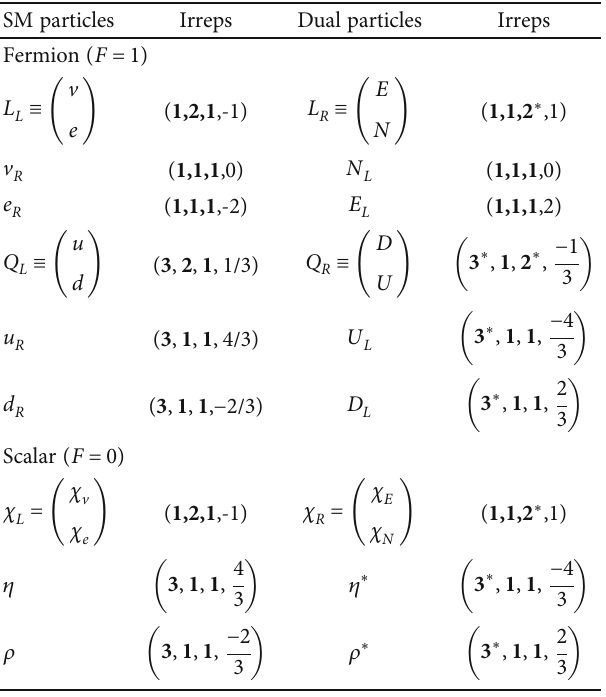
Table 1: Irreducible representation and quantum number assignment for the SM and the L-R dual particles with respect to the L-R gauge group and the global quantum number F . SM